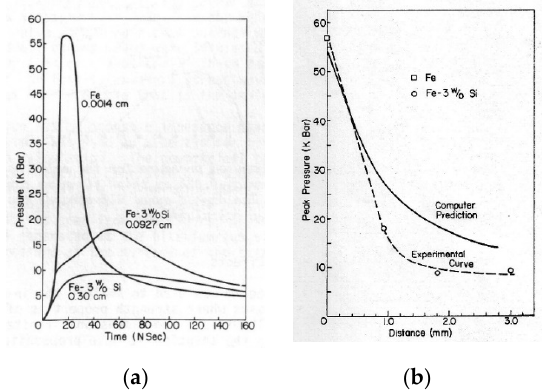
Figure 3. Pressure profiles and experimental and modeled peak pressure attenuation in Fe-3Si disks with a quartz overlay, 30 J/cm 2 , 30 ns pulse width: ( a ) measured pressure profiles through different thicknesses; ( b ) peak pressure attenuation through iron [16].